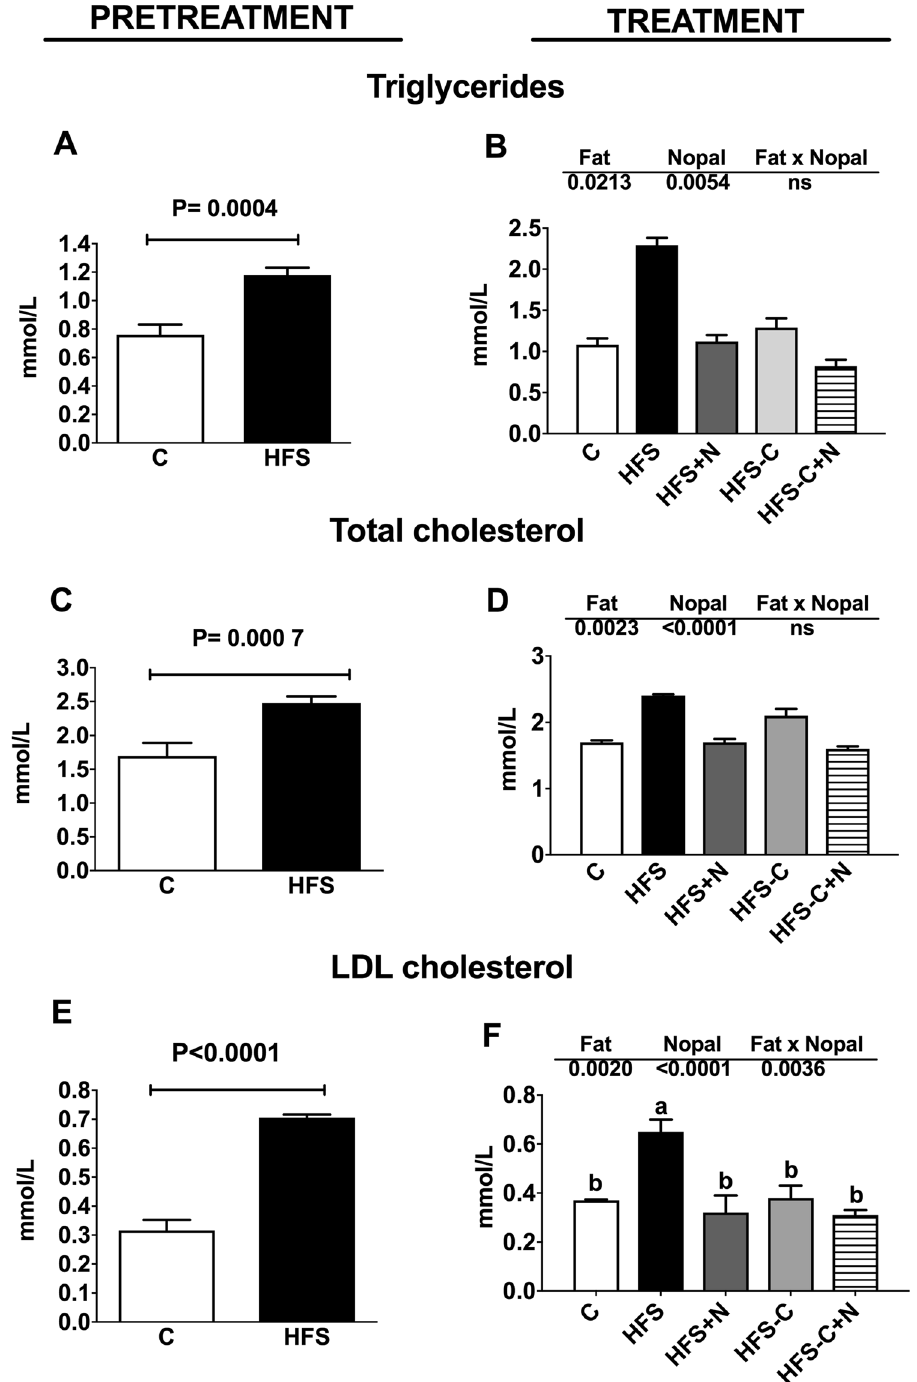
Figure 2. Effect of nopal consumption on blood lipids. ( A ) Fasting serum triglycerides, ( C ) total cholesterol and ( E ) LDL cholesterol of rats fed control diet ( C ) or high fat diet + 5% sucrose in drinking water (HFS) during 7 months (pretreatment period). After this period, obese rats were switched to one of the experimental diets for 1 month (treatment period): HFS, HFS + N, HFS-C, HFS-C + N; ( B ), ( D and F ). Values are shown as means ± SEM, n = 5. Statistical analysis of the pretreatment period was assessed by student t-test. Comparisons among groups after the treatment period were analyzed by two-way ANOVA followed by Fisher´s post-hoc test. Different letters indicate significant differences among groups, a > b > c > d, P < 0.05. Comparisons between 2 groups were analyzed by student t